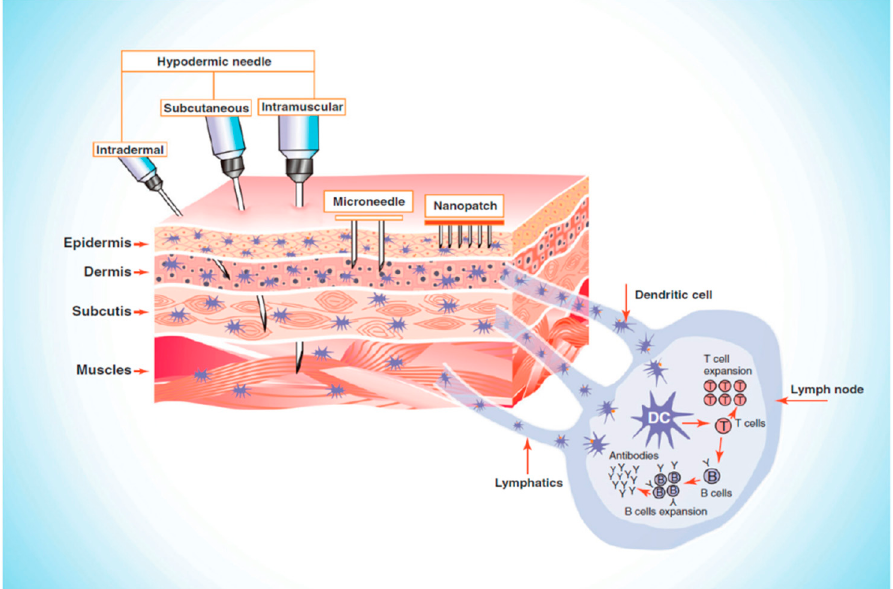
Figure 4. Illustrating the comparative penetration of hypodermic needle and microneedles (MNs), Reproduced with permission from [113], Elsevier, 2011.